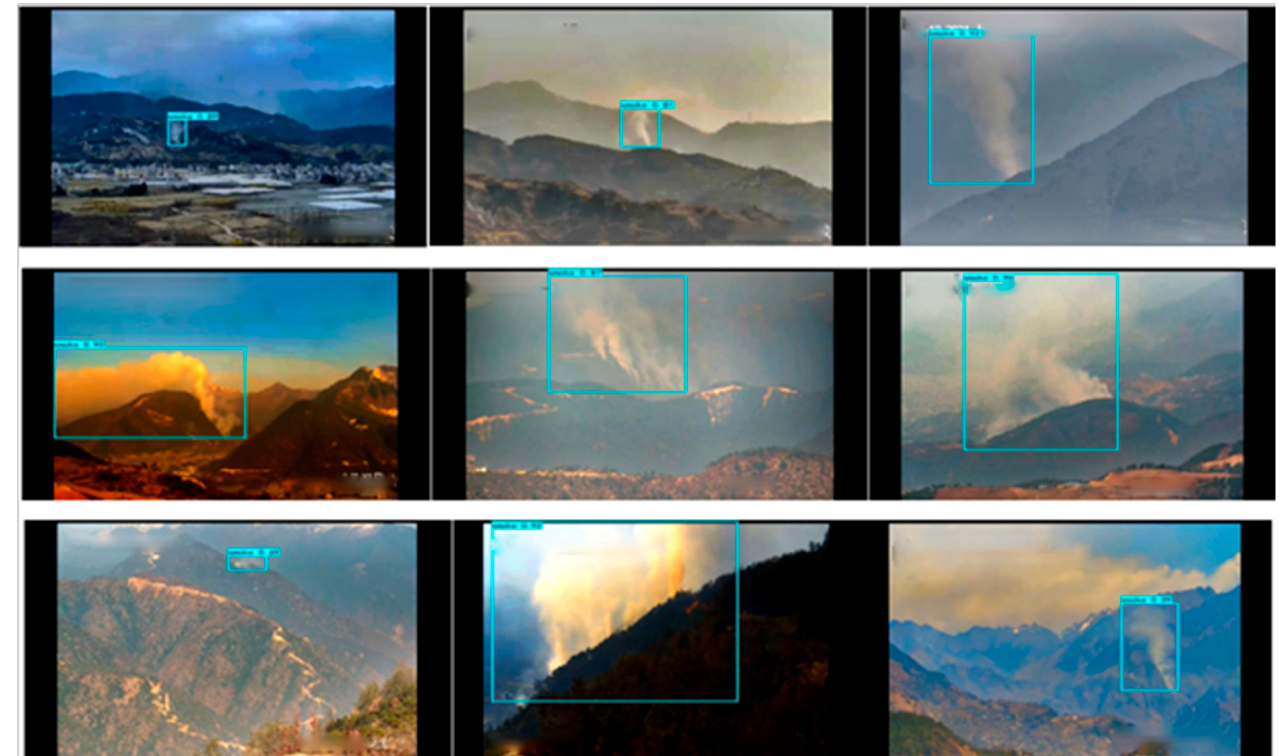
Figure 7. Detection results of fog environment of the GXLD.